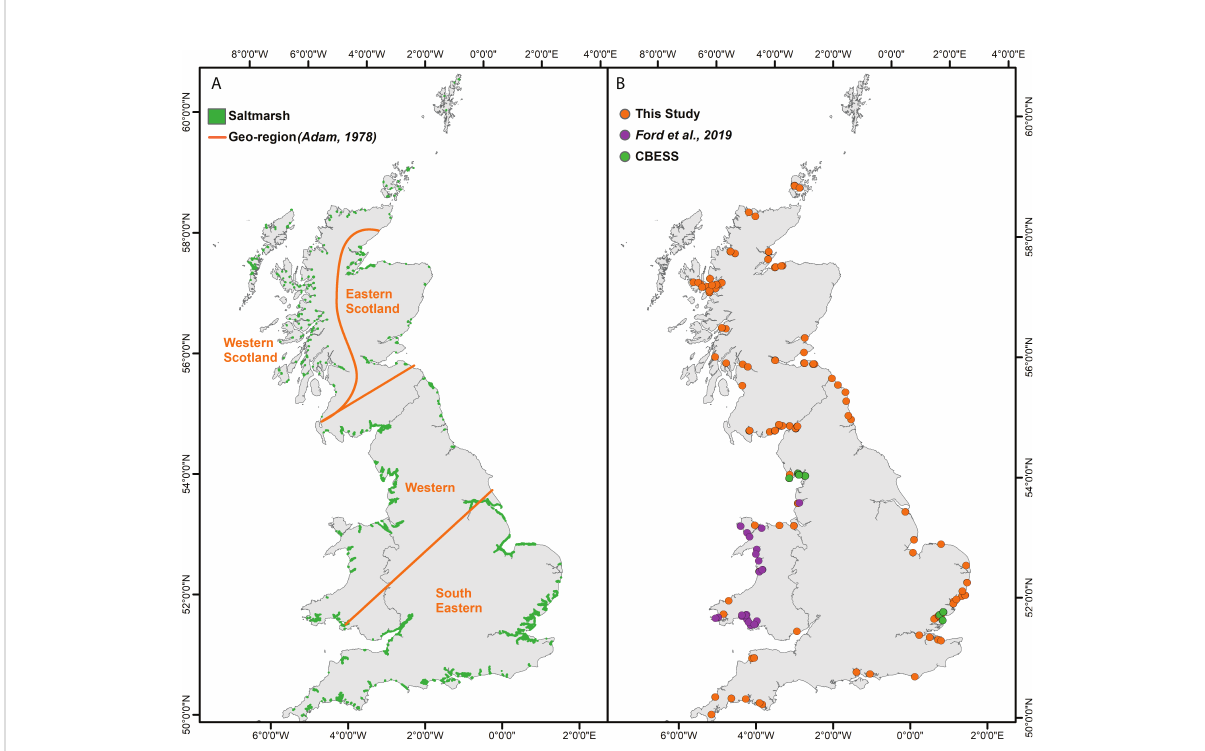
FIGURE 1 Saltmarshes of Great Britain. (A) Mapped extent of saltmarsh habitat across the nations of Great Britain ( exaggerated by 1.5 times for visibility ). Orange lines highlight the different saltmarsh vegetation geo-regions of Great Britain as described by Adam, 1978. (B) Sampling sites across Great British saltmarsh (orange dots) and the location of secondary data sources (green and purple